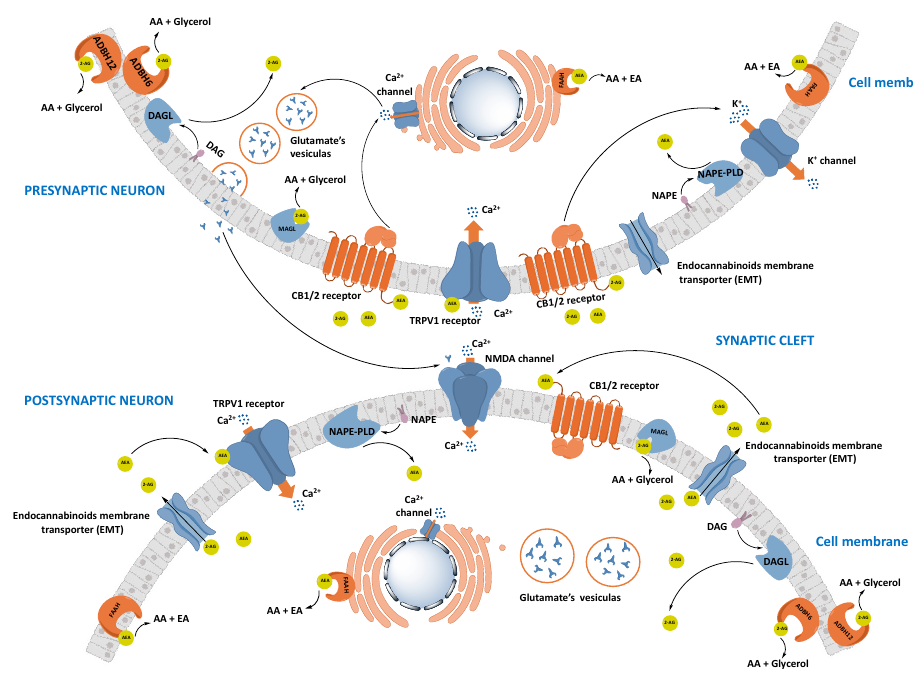
Figure 1. Retrograde signaling of ECS in a Glutamatergic synapse. Anandamide (AEA) and 2- arachidonoylglycerol (2-AG) are synthesized on demand in the postsynaptic neuron following an increment of Ca 2+ concentration. AEA is synthesized starting from the membrane lipid N - acylphosphatidylethanolamine (NAPE) by N -acyl-phosphatidylethanolamine-hydrolyzing phospholipase D (NAPE-PLD) activity, while diacylglycerol lipase (DAGL) converts the diacylglycerol (DAG) in 2-AG. AEA and 2-AG move across the cell membrane through a purported endocannabinoid membrane transporter (EMT). Cannabinoid receptor type 1/2 (CB 1/2 ) and transient receptor potential vanilloid 1 (TRPV1), are the main receptor targets of AEA and 2-AG on the presynaptic neuron. Activation of CB 1/2 receptors triggers the Ca 2+ -mediated release of glutamate, in the presynaptic neuron, with subsequent activation of NMDA receptors in the postsynaptic neuron. Moreover, the transduction pathway of CB 1/2- mediated determines the K + efflux which opposes the depolarization in the presynaptic neuron. AEA is hydrolyzed by FAAH enzyme while in the 2-AG catabolism are involved MAGL, ADBH6, and ADBH12 enzymes. The outcome of this process is the inhibition of glutamatergic activity. Moreover, eCB signaling can also proceed by a non-retrograde mechanism, in which AEA and 2-AG active CB 1 receptors or TRPV1 channel on the postsynaptic neurons.